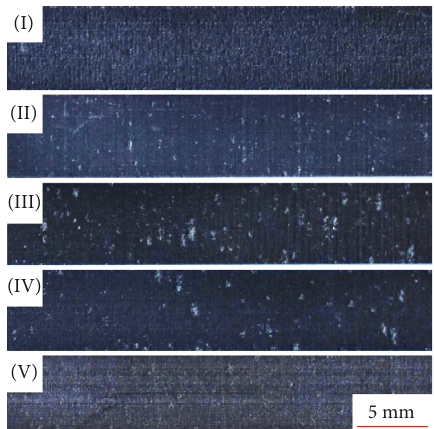
Figure 4: Surface morphologies machined at cutting thickness of 0.2 mm and different rake angles: (I) 10 ° , and (V) 20 °